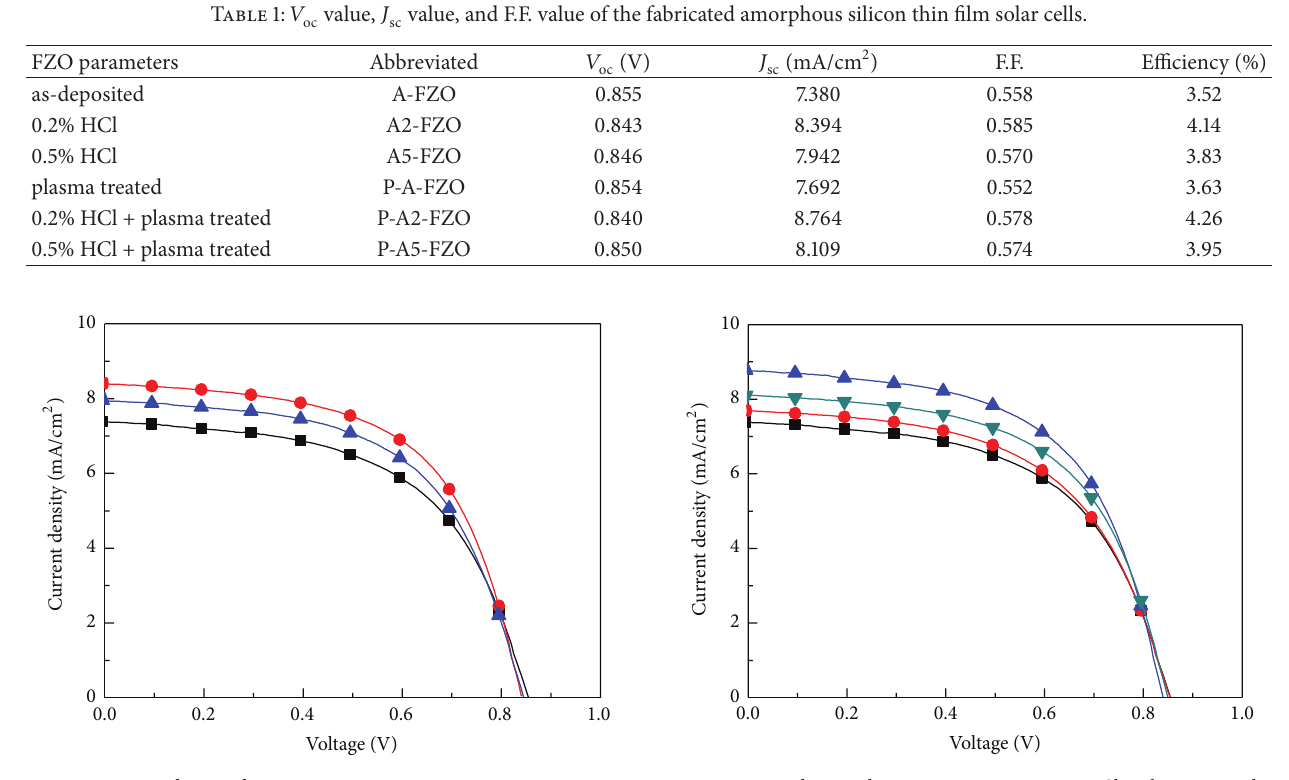
3.52 ± 0.17 , 4.14 ± 0.13 , and 3.83 ± 0.15 , respectively.